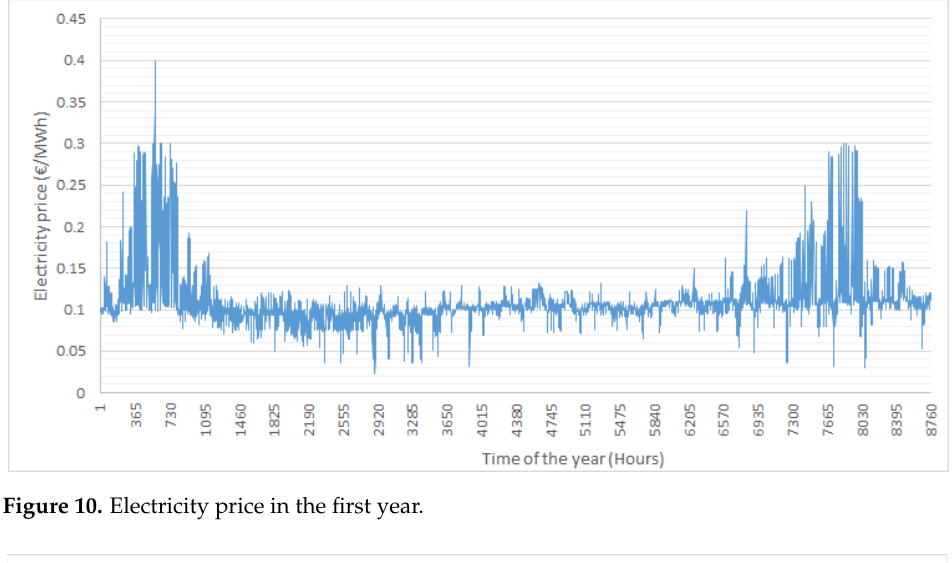
Figure 10. Electricity price in the first year.